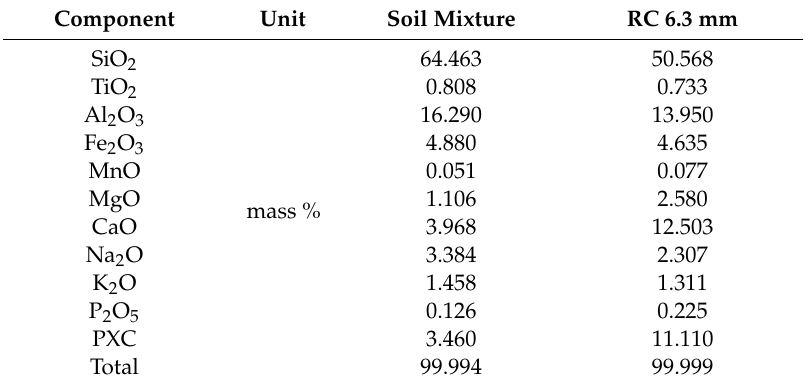
Table 10. X-ray fluorescence of excavation material and construction waste.